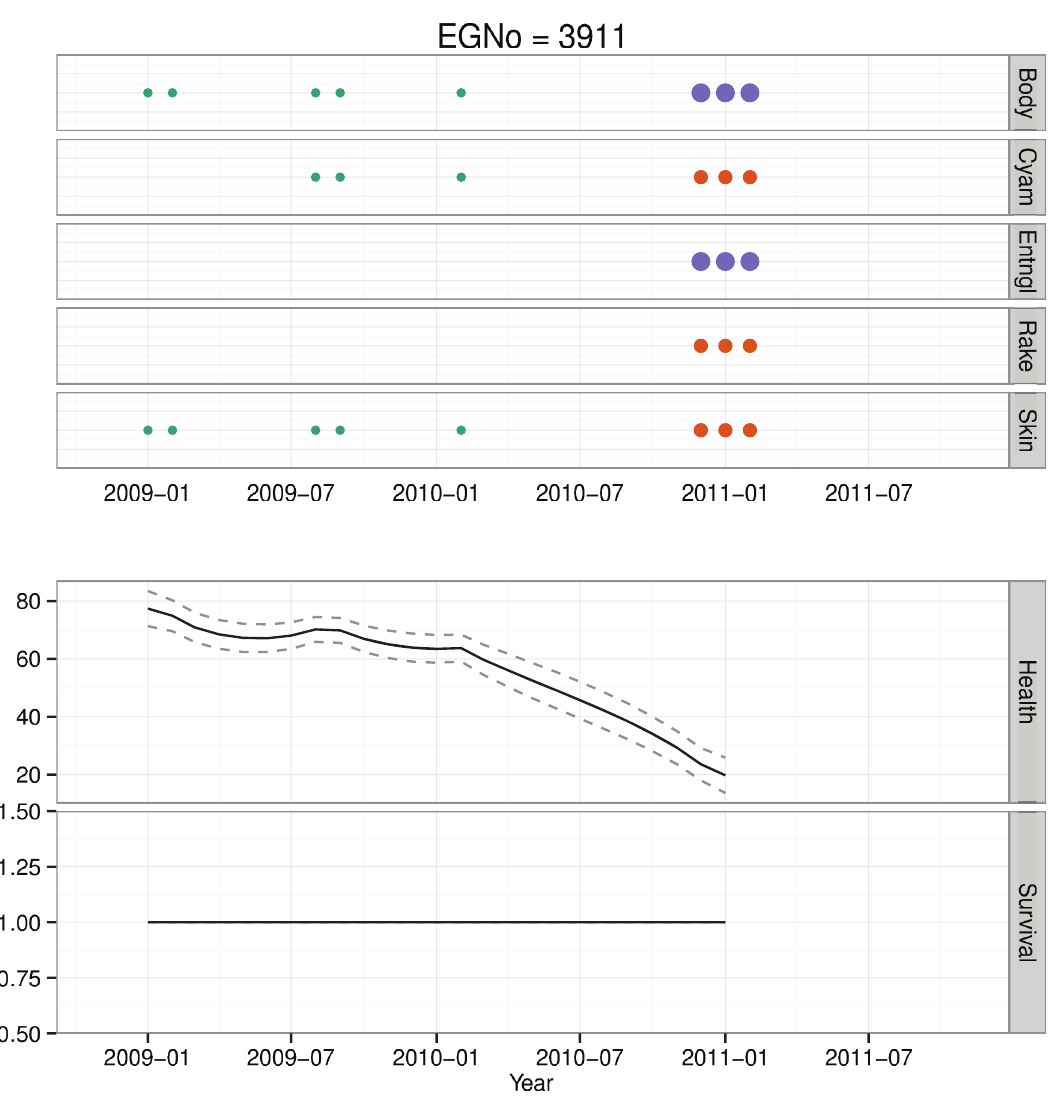
Figure 10. Health time series for whale # 3911. Photographic observations of H are color and size coded as in Figure 8. # 3911 was only alive briefly, had declining health towards the end her life as a result of a severe entanglement, and was observed dead in February of 2011.